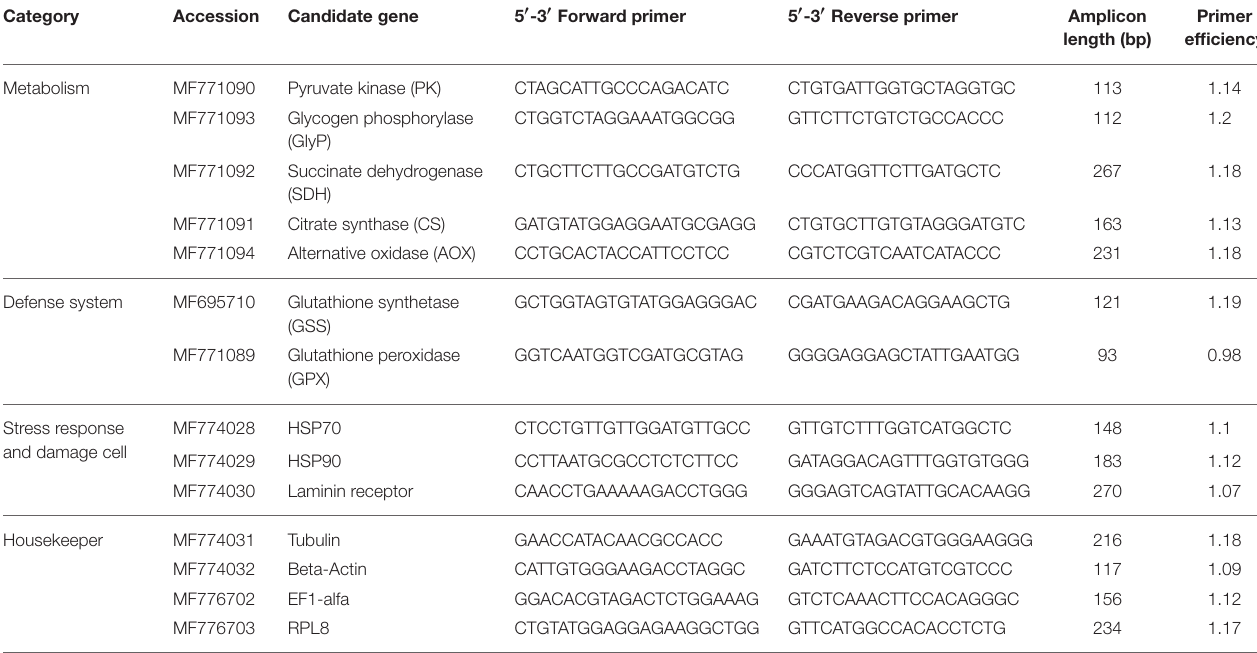
TABLE 1 | Genes and primers used for qPCR analyses in D. chilensis